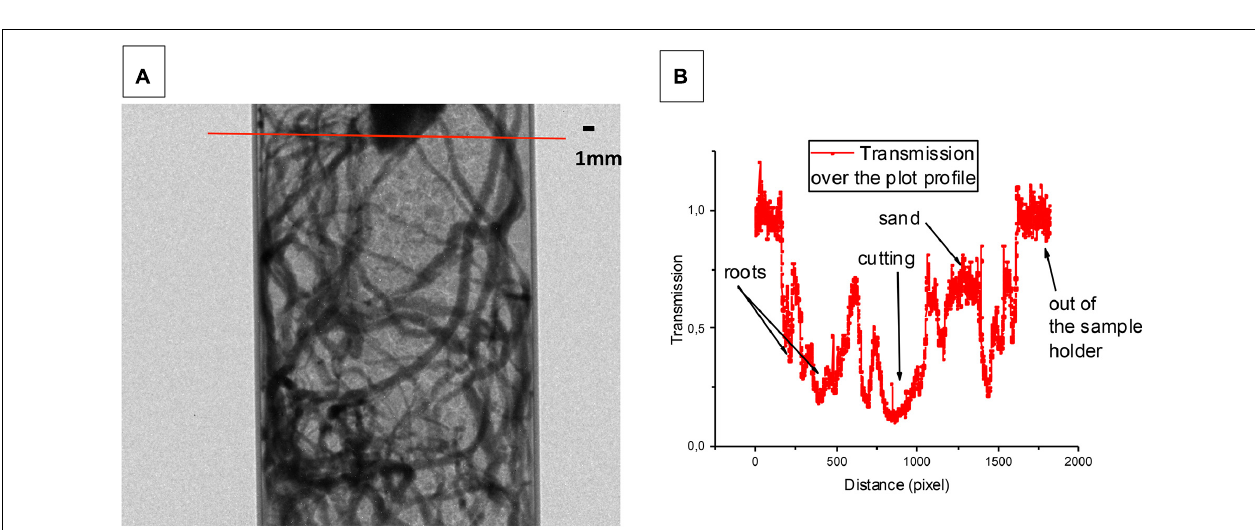
FIGURE 7 | Neutron radiography of grapevine root and sand in an aluminum sample holder. The image (A) has been obtained with an exposure time of 80 s. The experimental resolution of the pixel is 15.2 µ m which allows observing both the adventitious roots and its laterals. An example of a transmission profile is presented (B) . The transmission of the sand is around 0.8 whereas the one of the roots is going from 0.4 to 0.2. This difference of transmission between the sand and the roots corresponds to a contrast which allows to clearly distinguishing the roots from the soil (The image analysis has been performed by using the free access Image J 1.48